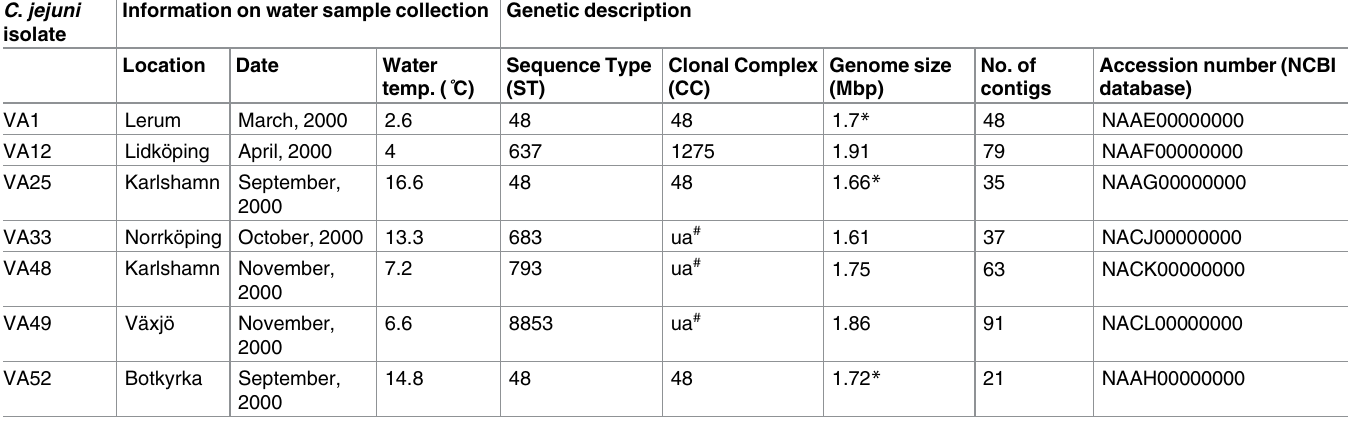
Table 1. Water sample collection information and genetic description for the C . jejuni water